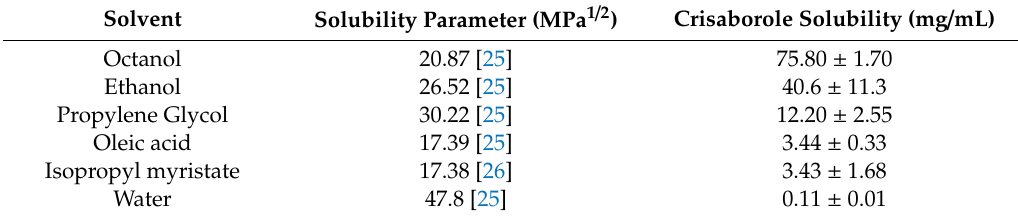
Table 1. Solvent properties and crisaborole solubility (average values ± sd).